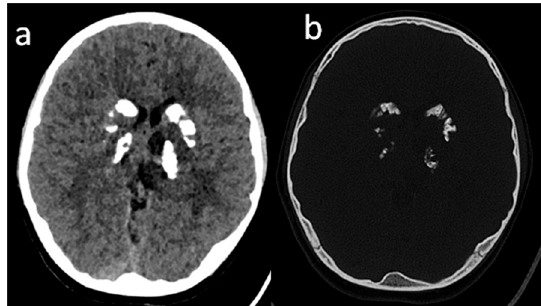
Figure 1. Head CT, axial plane, ( a ) soft tissue window; ( b ) bone window: bilateral, symmetrical and multifocal calcification in deep structures (basal ganglia) and dentate nuclei (not shown).